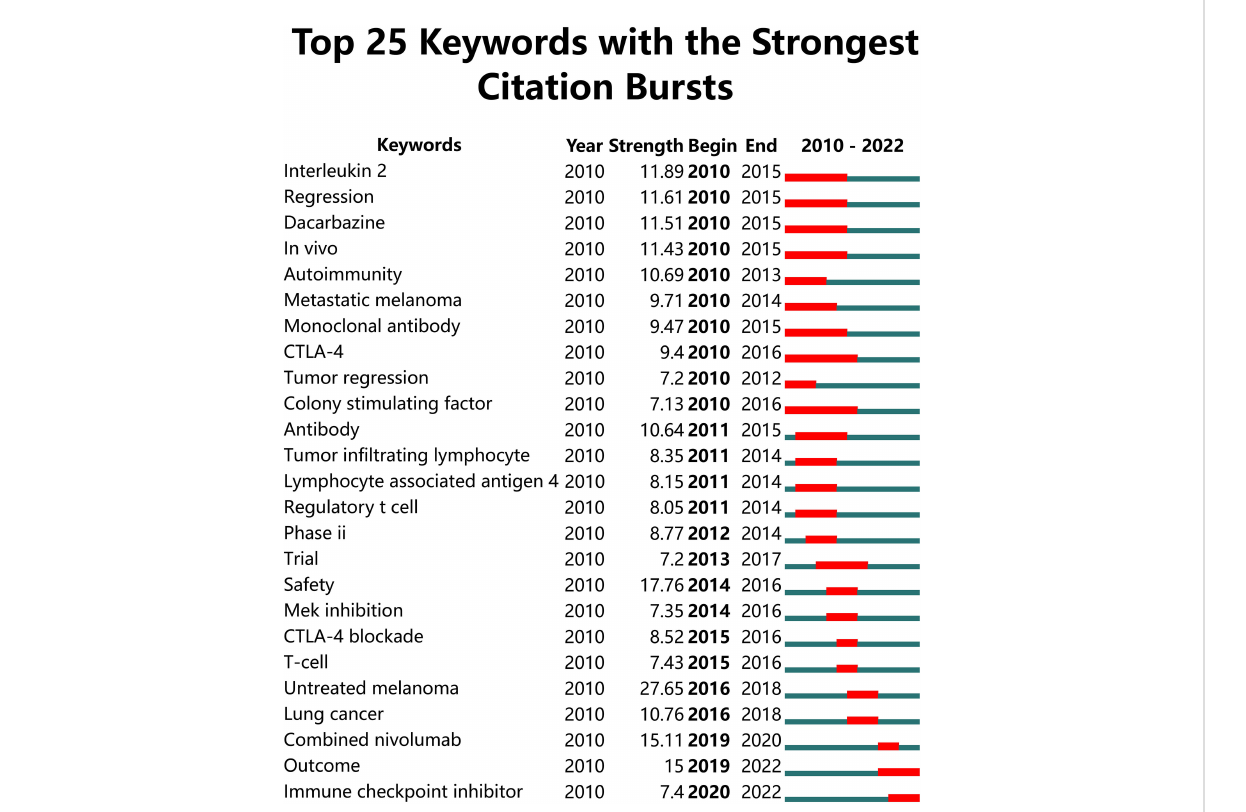
FIGURE 7 Top 25 keywords with the strongest citation bursts in papers on melanoma immunotherapy. The green line represents the timeline and the red line on the timeline represents the burst duration from the start year to the end